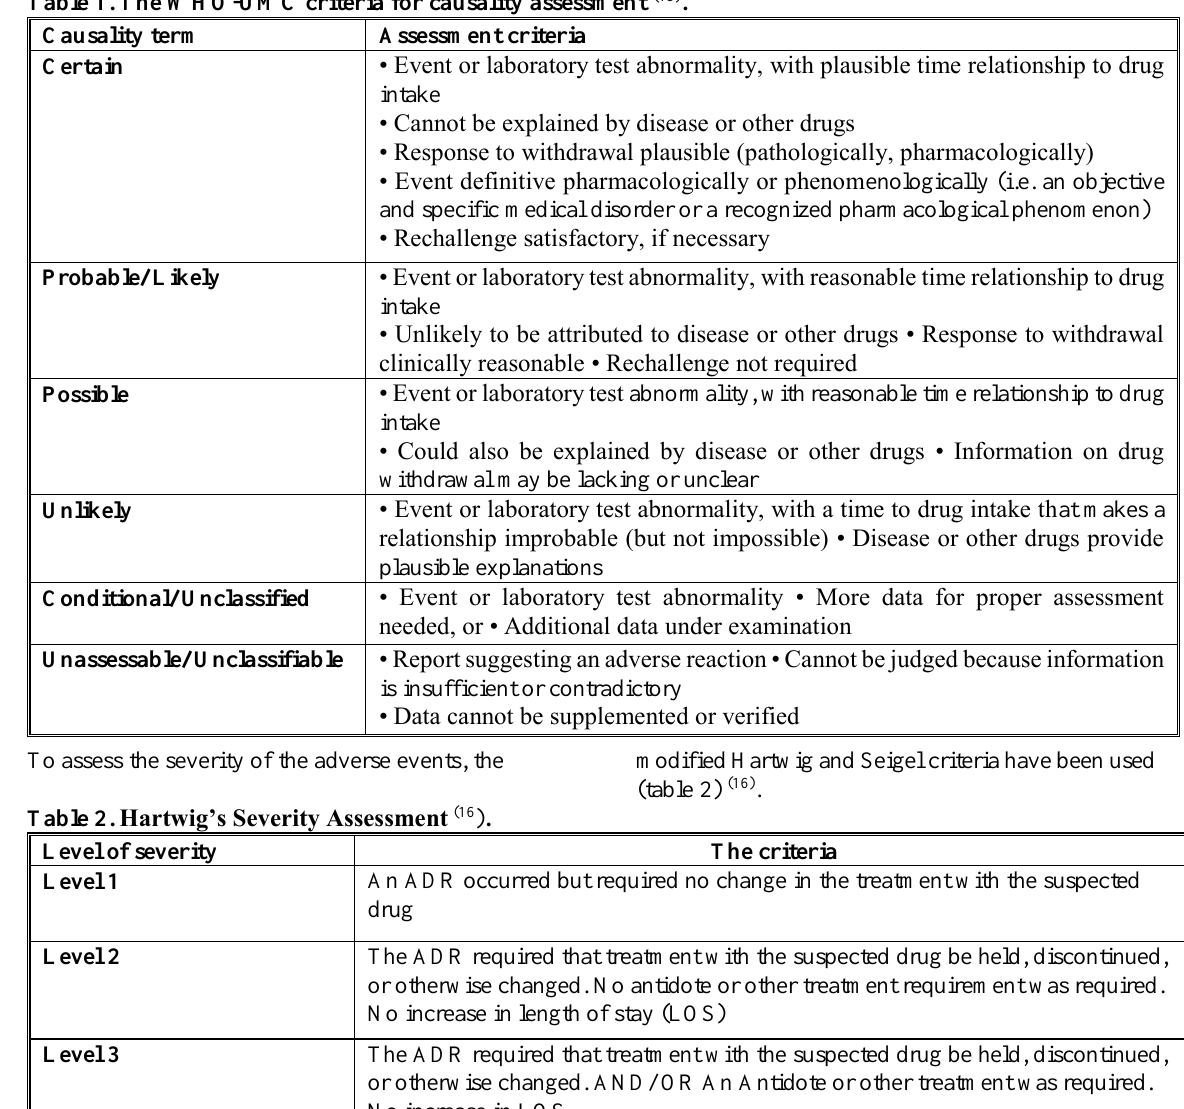
Table 1. The WHO-UMC criteria for causality assessment (15) . Causality term